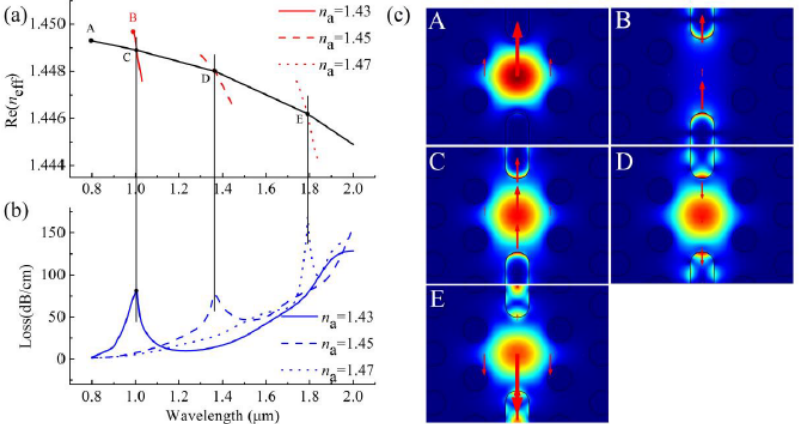
Figure 19. ( a ) Real part of the y-polarized core mode (black solid curve) and y-polarized surface plasmon polariton (SPP) mode at analyte RI of 1.43, 1.45, and 1.47 (red solid, red dashed, red dotted curves); ( b ) Imaginary part or loss spectra of the y-polarized core mode at analyte RI of 1.43, 1.45, and 1.47; ( c ) y-polarized electric field distributions of core mode and SPP mode at different wavelengths (A for core mode at 800 nm, B for SPP mode at 992 nm, C for core mode at 1006 nm with n a = 1.43, D for core mode at 1367 nm, and E for core mode at 1791 nm with n a = 1.47). Figure reproduced under